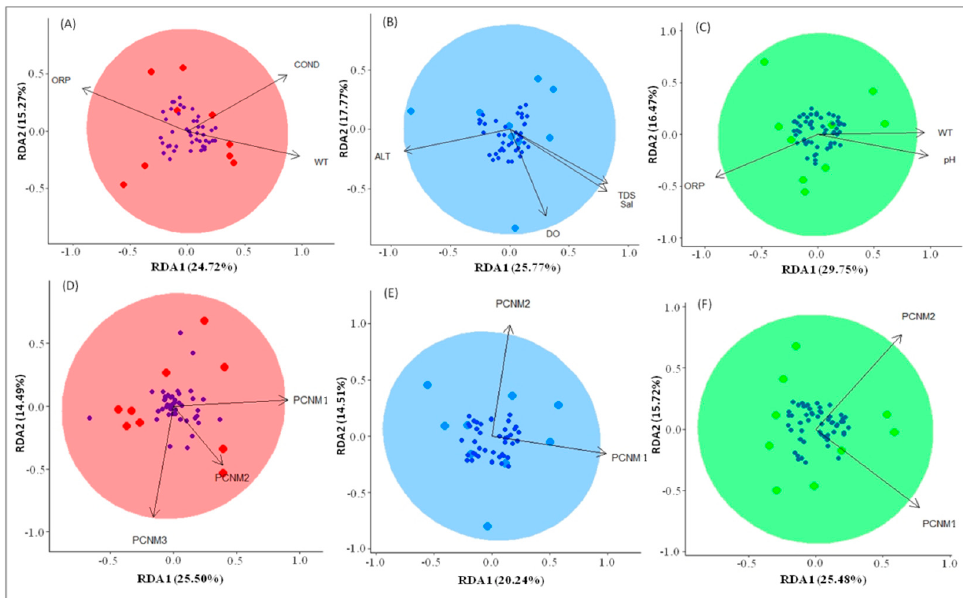
Figure 6. RDA model of the macroinvertebrate communities for environmental and spatial com- ponents of each period. The first three graphs represent the relationship between environmental variables and communities in each period i.e., ( A ) = 2017, ( B ) = 2018, and ( C ) = 2019. The ( D ) = 2017, ( E ) = 2018, and ( F ) = 2019, represent the relationship between spatial factors and communities. The significant spatial and environmental factors were selected based on the forward selection procedure ( p < 0.05).